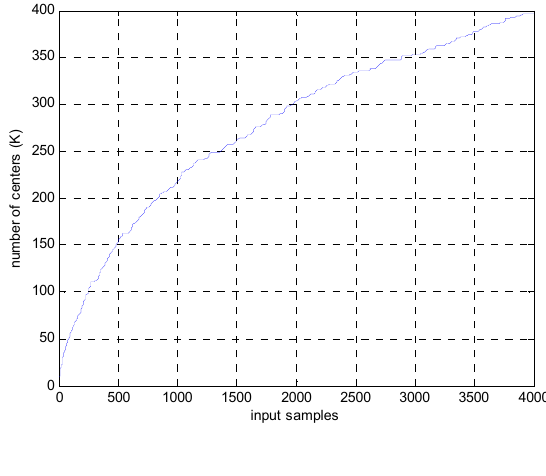
Figure 4. Dictionary size vs. input samples for the novel